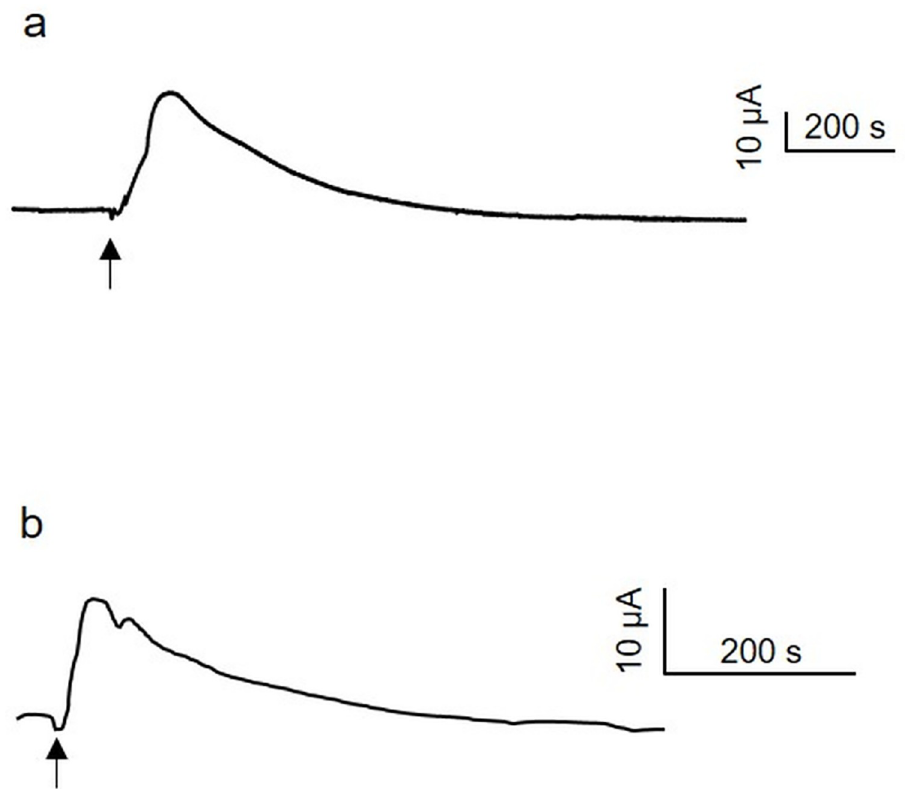
Fig 1. Traces of the secretory response to serosal pressure application (P ser ). Representative short circuit current traces evoked by P ser in (a) human sigmoid (20 mmHg) and (b) porcine transverse (60 mmHg) colonic tissue. Arrows indicate onset of P ser lasting for 60